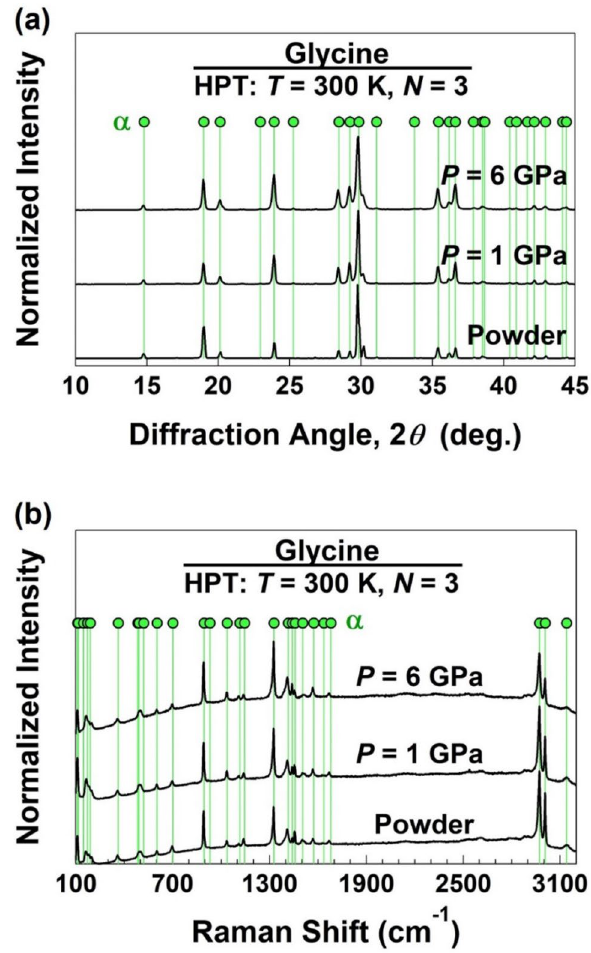
Figure 2. Absence of phase transformation in glycine after high-pressure torsion processing. ( a ) XRD profiles and ( b ) Raman spectra of glycine before and after processing under 1 and 6